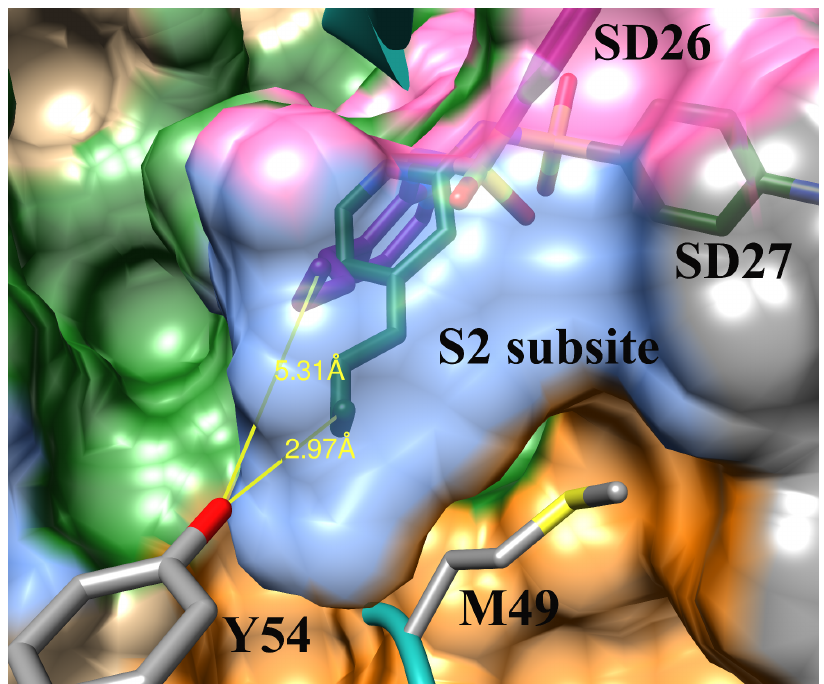
Figure 8. SD26 (purple) and SD27 (green) penetration into the S2 subsite (blue surface) SARS-CoV-2 M pro active site. Depth of penetration by SD27 is 3.22Å deeper than